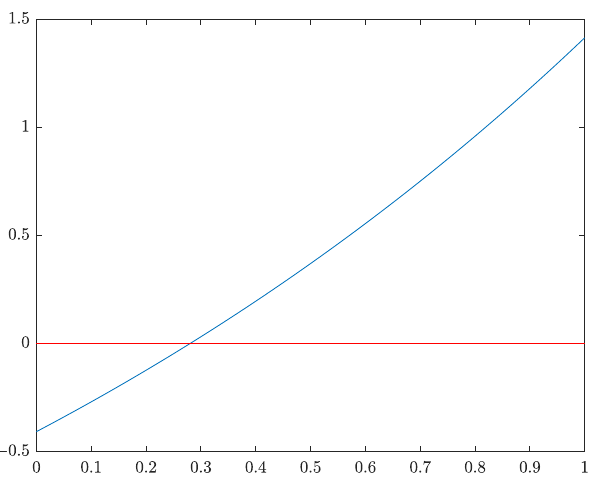
Figure 1. Graph of equation g ( t )